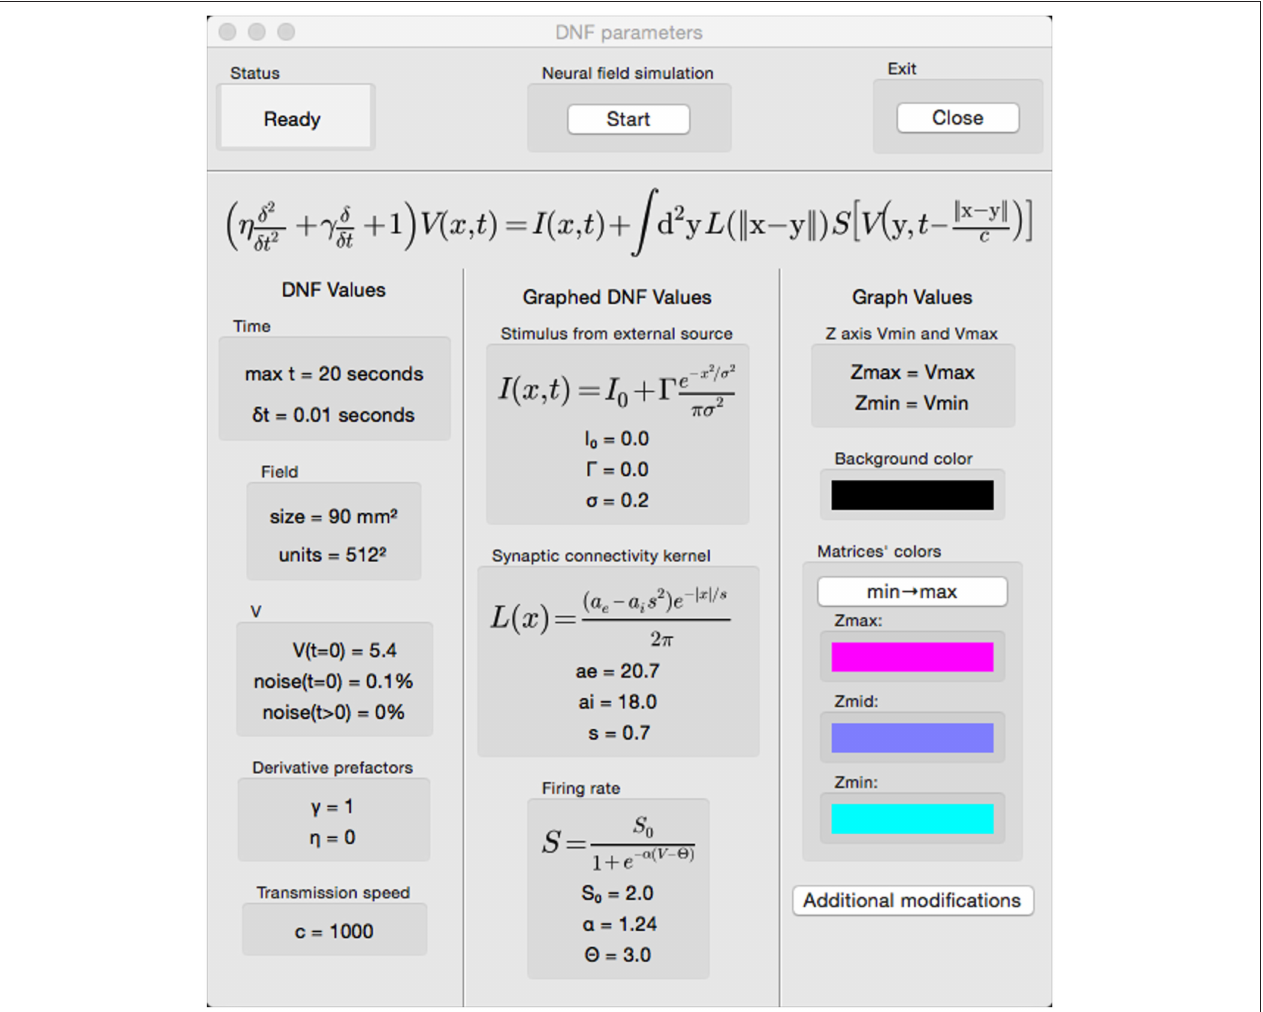
FIGURE 8 | A graphical interface for the